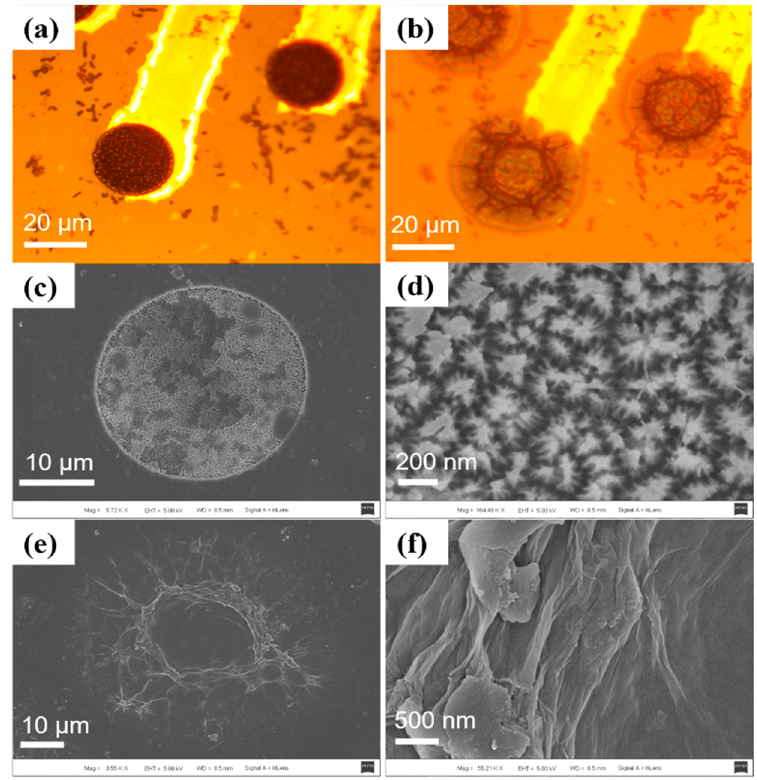
Figure 1. Micrograph of ( a ) PBK modified microelectrode and ( b ) PBK/PGO modified microelectrode. SEM pictures of ( c , d ) PBK modified microelectrode and ( e , f ) PBK/PGO modified microelectrode with large effective surface area.